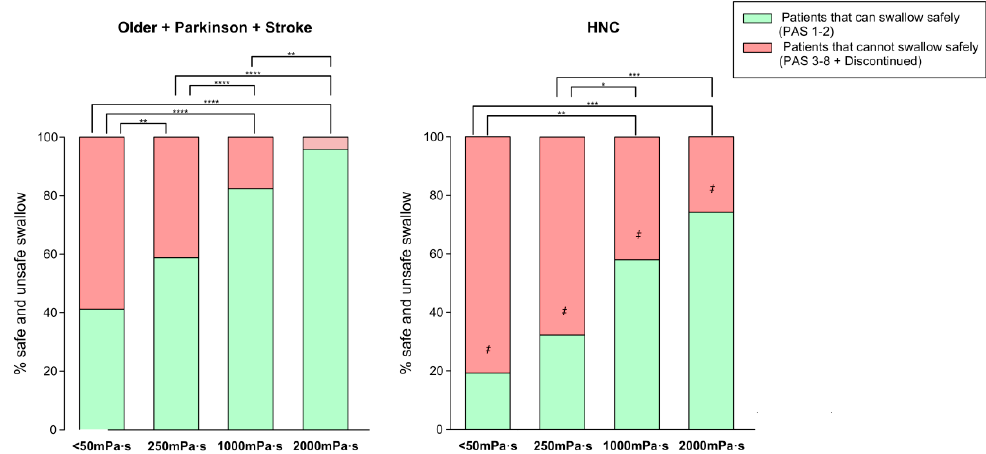
Figure 5. Percentage of patients who could swallow safely vs. those that cannot swallow safely comparing three groups together against HNC. Left: older, Parkinson’s and stroke patients; right: patients with head and neck cancer. * p -value < 0.05, ** < 0.01, *** < 0.001, **** < 0.001. ‡ p -value < 0.05 Older + Parkinson’s + Stroke. HNC: Head and neck cancer.